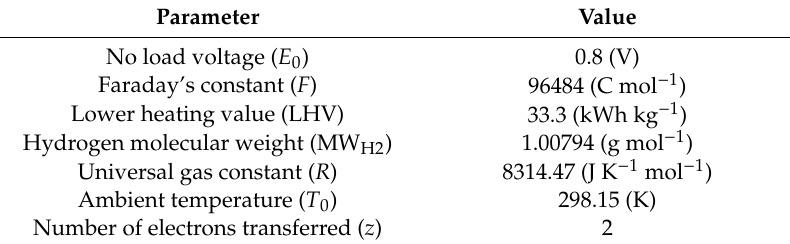
Table 1. Main fuel cell system